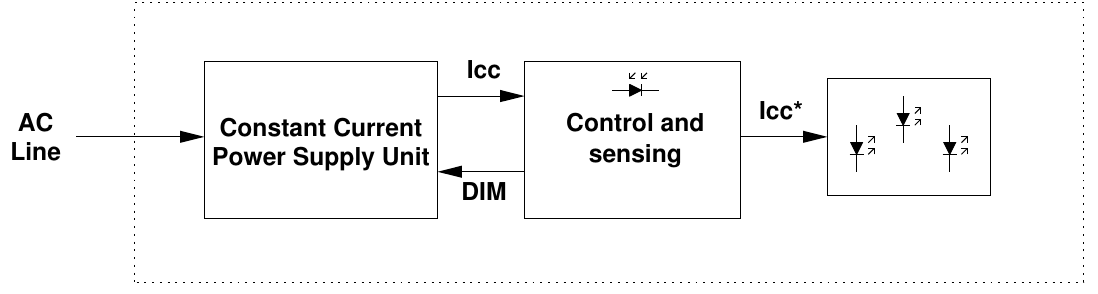
Figure 2. Modified LED